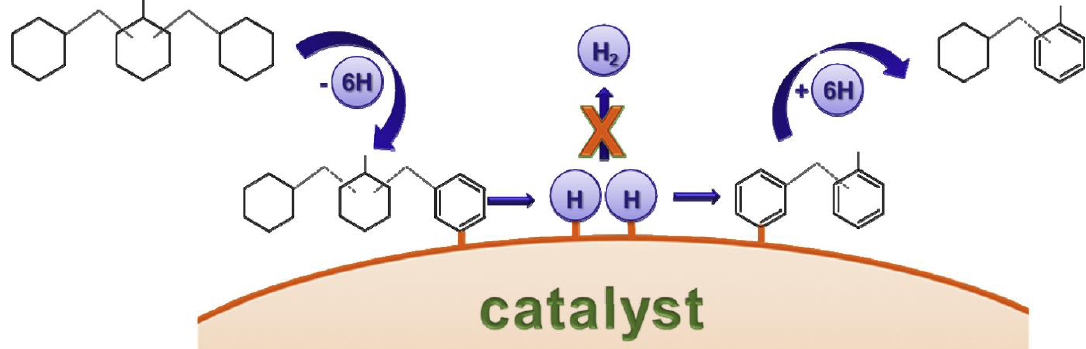
Figure 6. Reaction scheme of the proposed reaction mechanism for the transfer hydrogenation between H2− benzyltoluene and H2+ dibenzyltoluene. Reprinted with permission from [82].